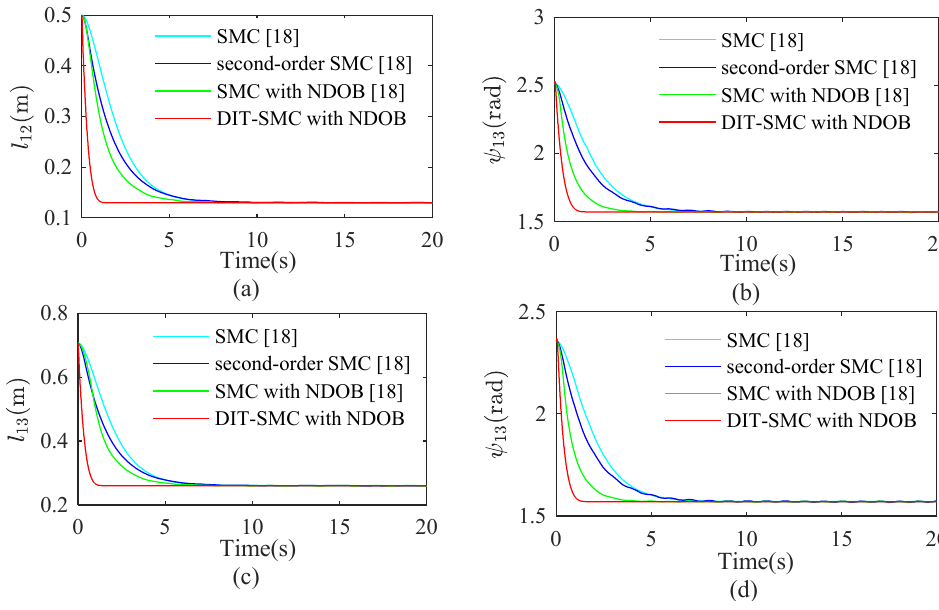
Figure 4. Relative distance and anger of leader–follower framework; ( a ) l 12 ; ( b ) ψ 12 ; ( c ) l 13; ( d ) ψ 13 . Figure 5 denotes the control input of follower robot 2 using different control method. In Figure 5a, the acceleration of follower robot 2 are shown, while the angular accelerations of follower robot 2 are displayed in Figure 5b. From Figure 5a,b, the control input of DIT-SMC based NDOB is smoother than other control methods, which denotes the acceleration and angular acceleration are more stable.